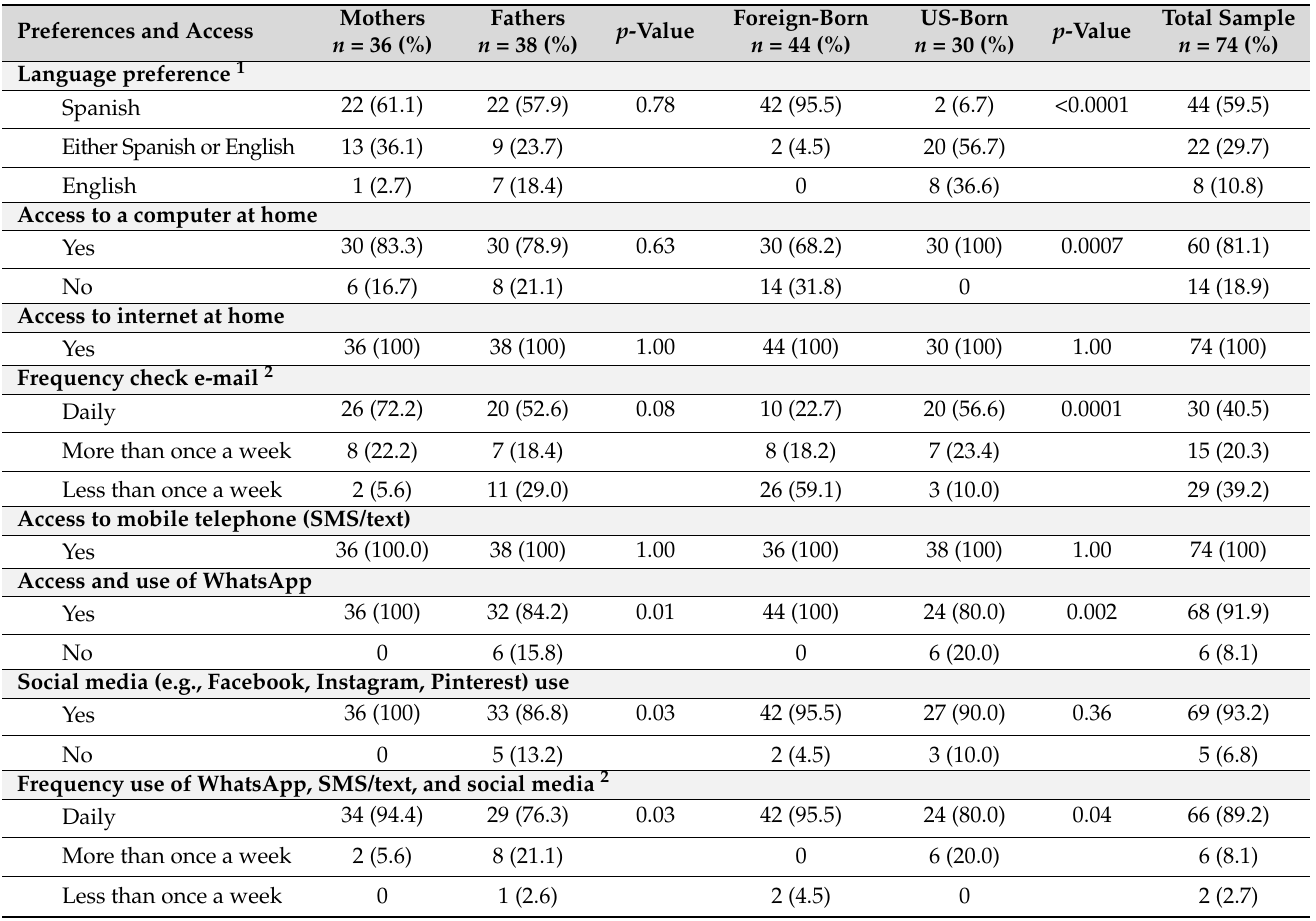
Table 4. Participants’ language preferences for receipt of information and communication technology access and frequency of